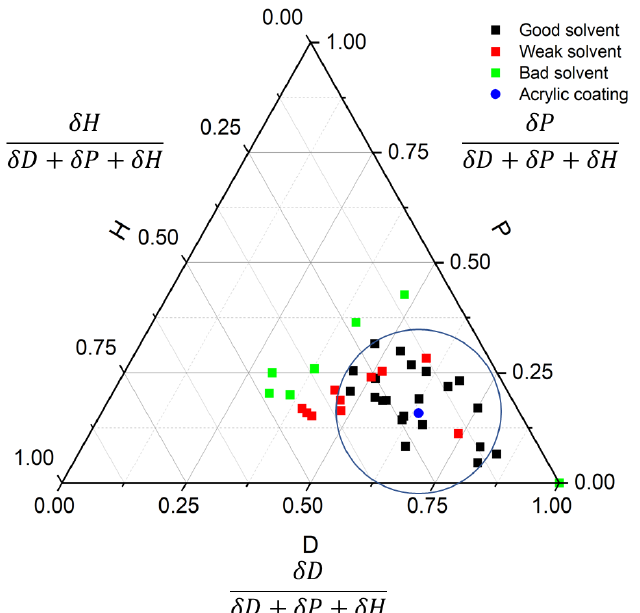
Figure 3. The Hansen solubility parameters (HSP) values (D = 16.5, P = 4.1, H = 5.3, with a radius of 6.8) of the acrylic coating determined by testing 39 solvents.